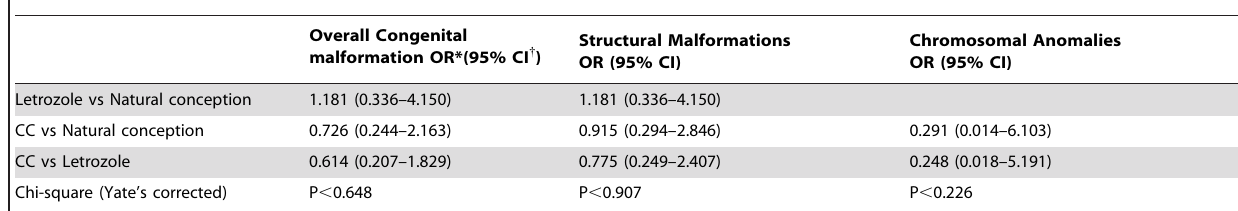
Table 4. Comparison of Congenital Malformations between Different Groups.